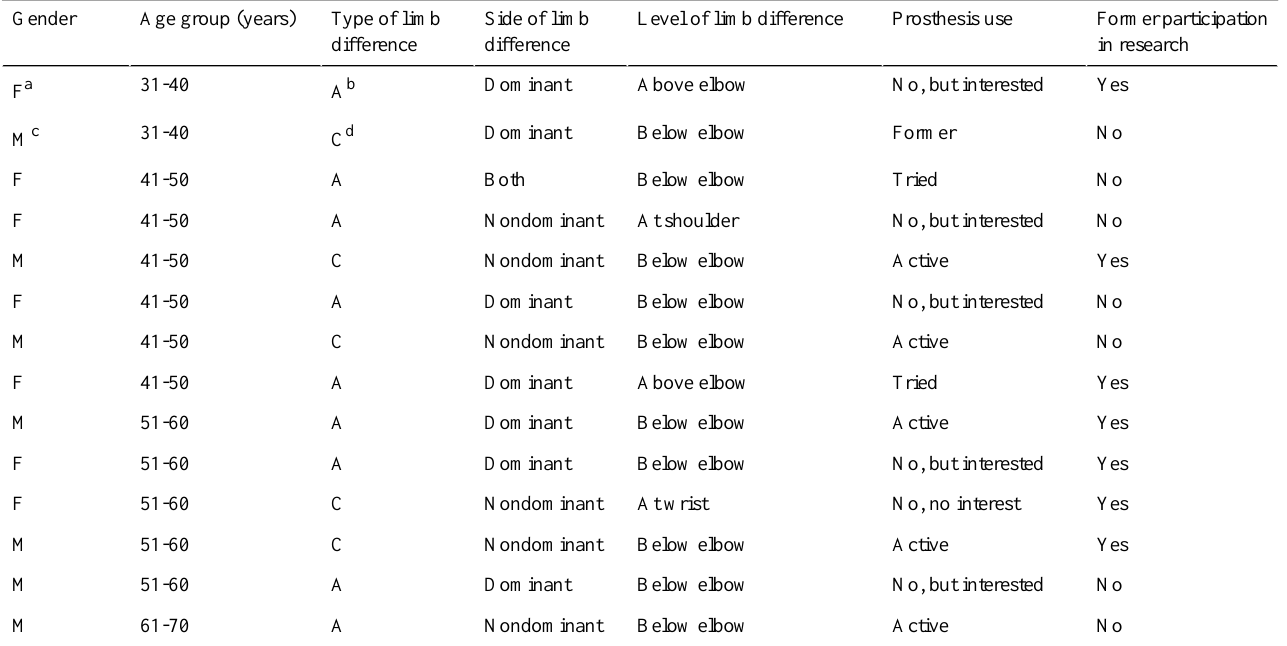
Table 1. Participants’demographics.